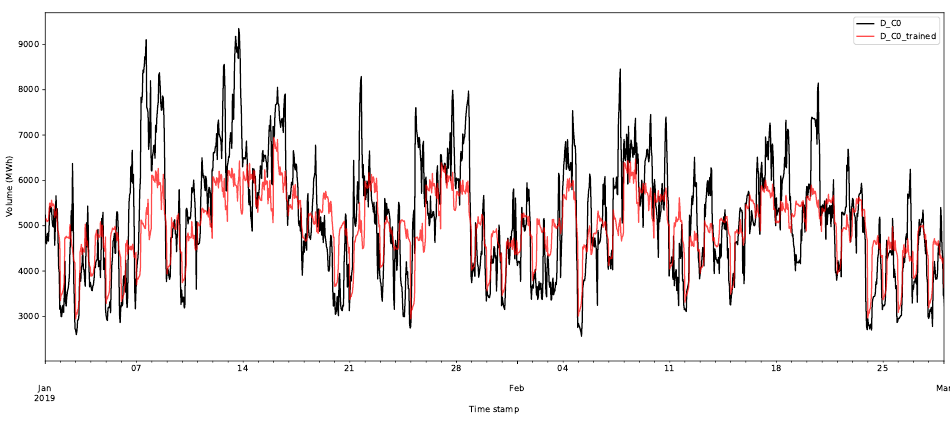
Figure 11. Example of day-ahead forecasting for the first demand class for the first two months of the test set. The actual values are in black and the forecast values are in red.